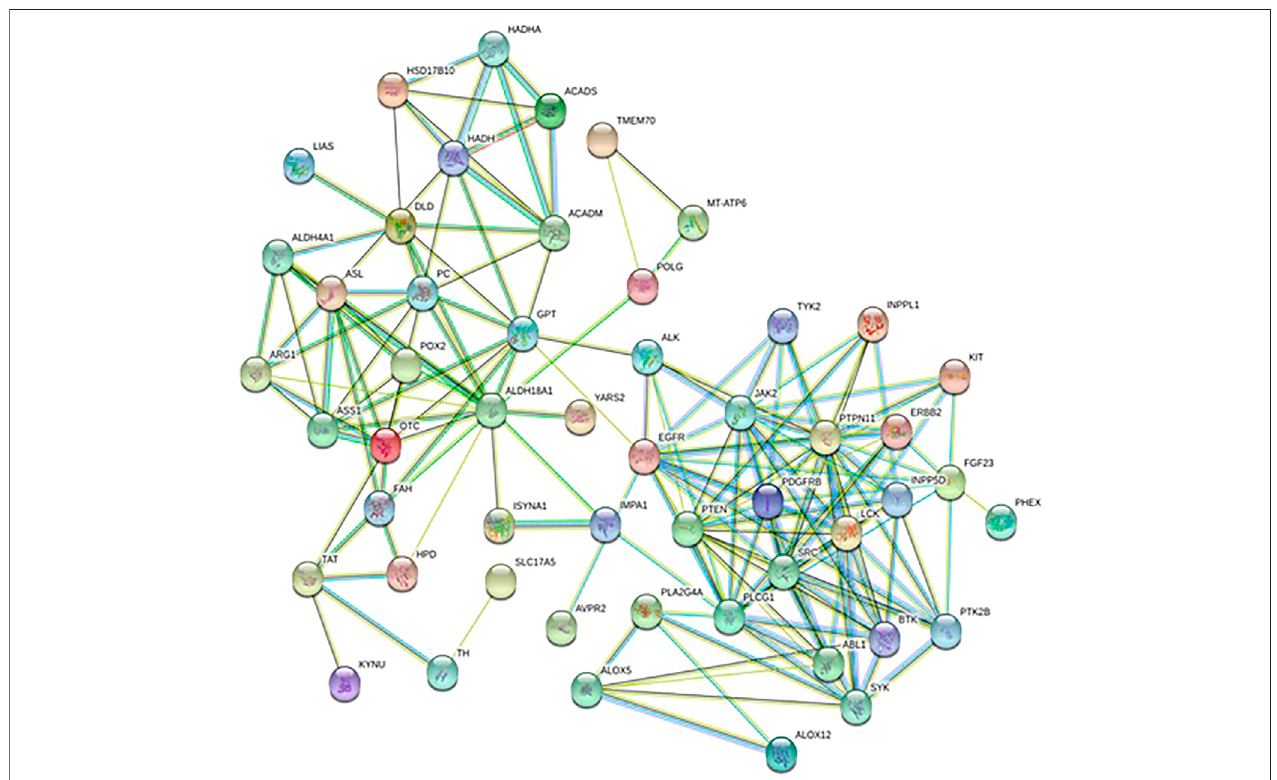
FIGURE 7 | Protein-protein correlation analysis of differentiated metabolites involved in Andro treatment protecting against lung cancer mouse.